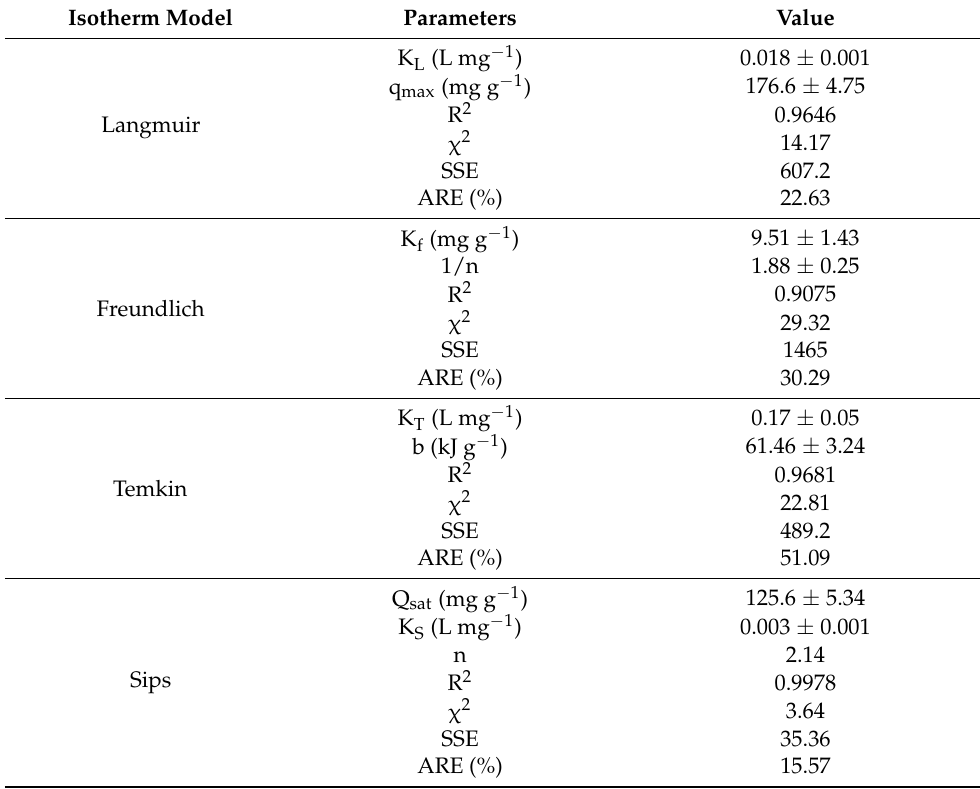
Table 1. The tested isotherms models’ constants and the corresponding statistical parameters.